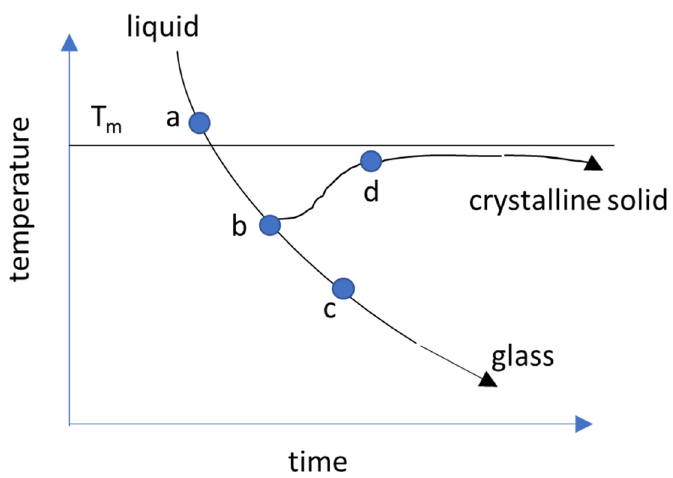
Figure 3. Quenching or cooling curve in glass vs. crystal formation. (Tm is the equilibrium melting temperature; a–b–d denotes path for nucleation and crystal growth; a–b–c denotes path of glass formation (Adapted with permission from [31]).